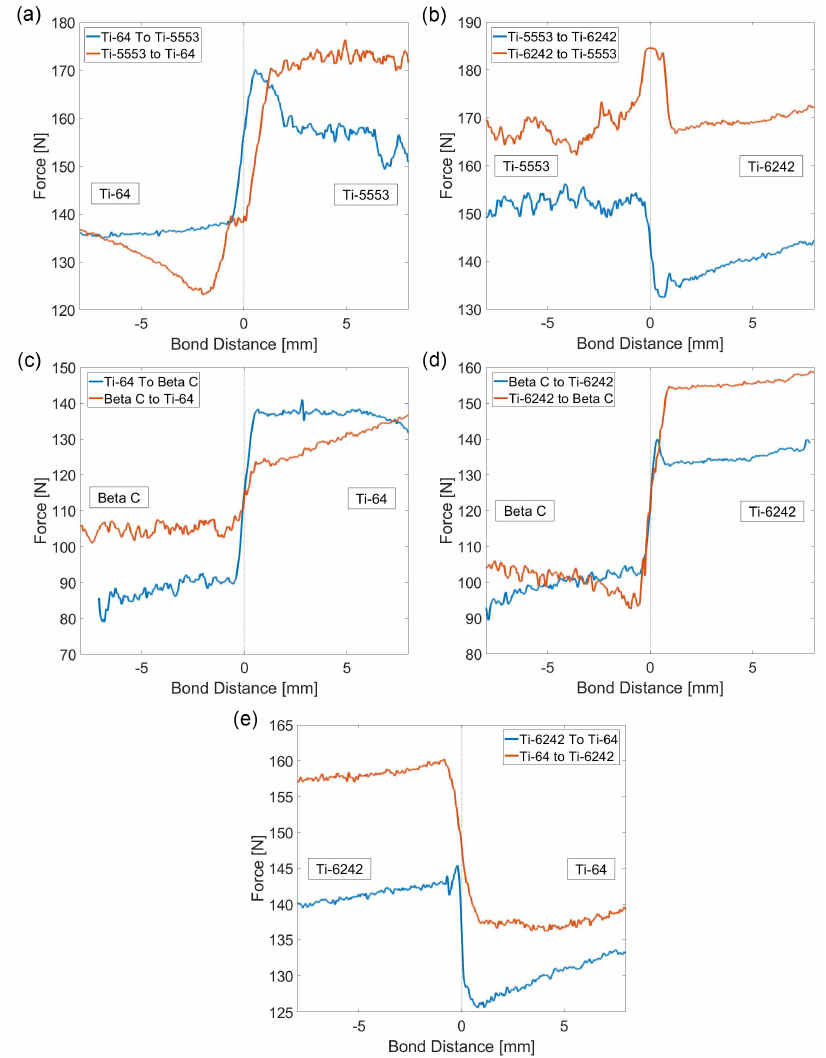
Figure 7. Plots of the average Fz profile for both machining directions for each titanium alloy bond pairing. The dash line at 0 represents the location of the bond. ( a ) Ti-64/Ti-5553, ( b ) Ti-6242/Ti5553, ( c ) Ti-64/Beta C, ( d ) Ti-6242/Beta C and ( e )